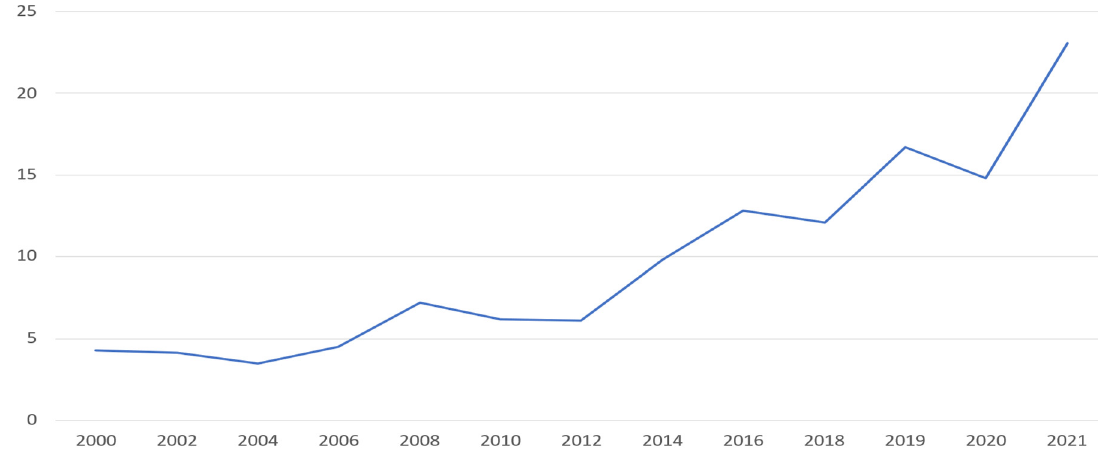
Figure 10. Home Purchases by Investors (Percent share). Source: Corelogic.